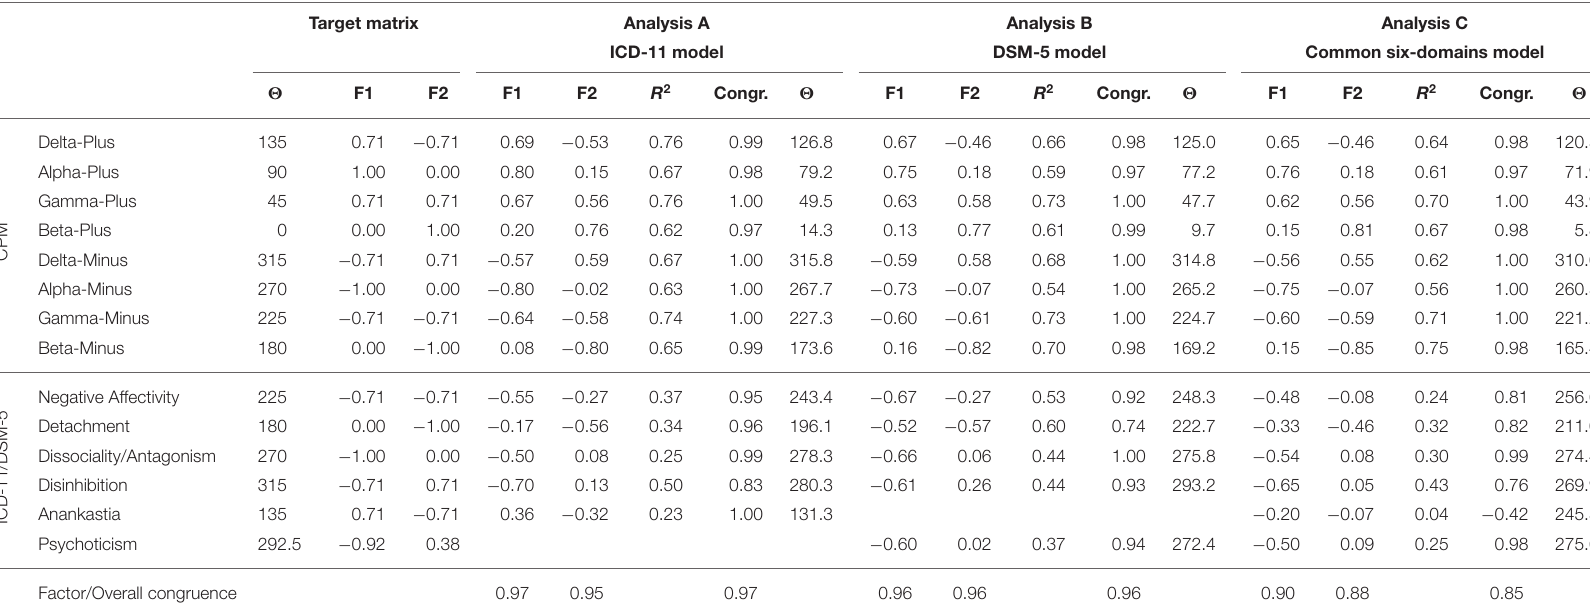
TABLE 5 | Target and obtained factor matrices with corresponding CPM angles, explained variances, and congruence coefficients for comparing target and obtained factor loadings of CPM metatraits, ICD-11 and DSM-5 psychopathological trait-domains in three analyses conducted in Study 2 ( N =